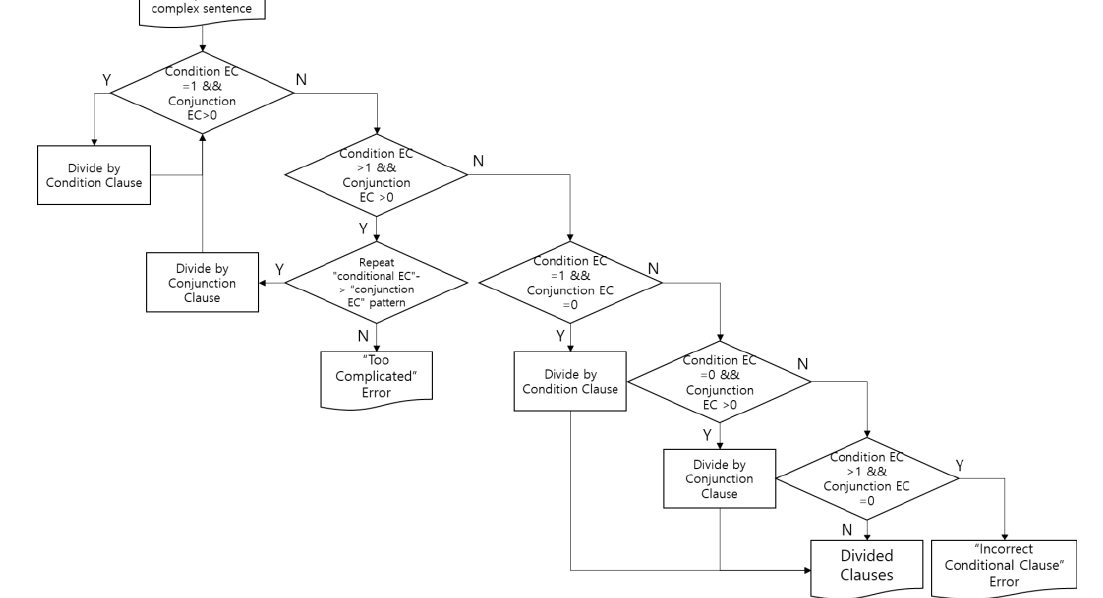
Figure 6. The clause order algorithm for identifying the priority of each connective ending (EC) of clauses in a sentence.